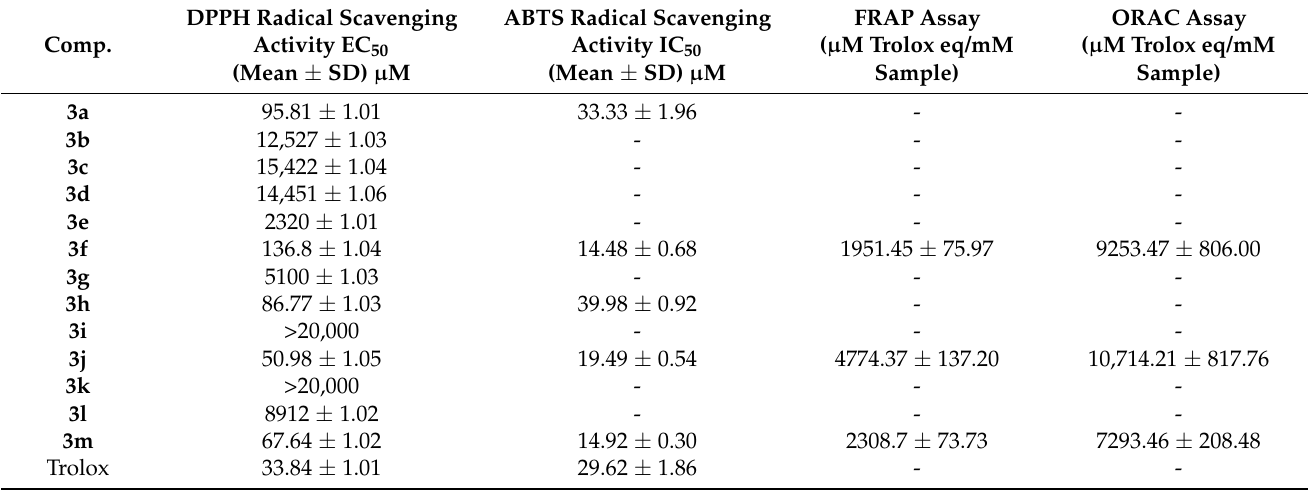
Table 3. Results of the in vitro radical scavenging activity assays (DPPH, ABTS, FRAP, and ORAC).